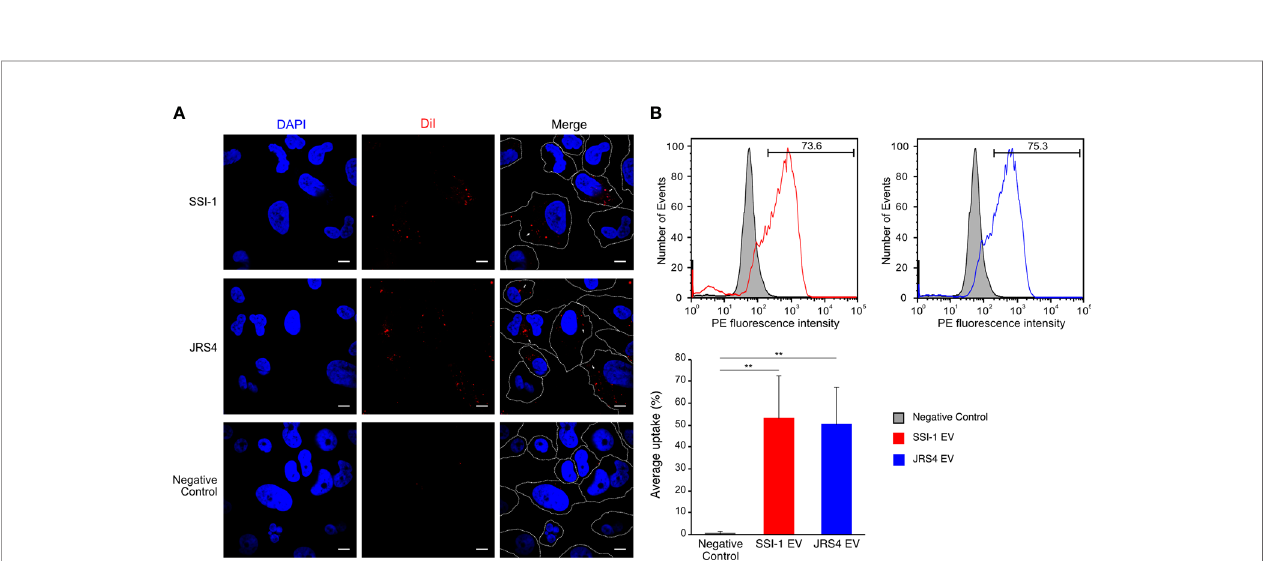
FIGURE 4 | Uptake of DiI-labeled EVs and the ef fi ciency in dTHP-1 cells. (A) The dTHP-1 cells were co-incubated with 10 µg of DiI-labled EVs (red) solution for 2 h at 37°C and 4°C (shown in Supplementary Figure 3 ) and observed by confocal fl uorescence microscopy. Cellular DNA was stained with DAPI (blue). Scale bar, 5 µm. Dot lines indicate the border of individual cells. (B) Flow cytometric analysis of the fl uorescence transferred by EVs into dTHP-1 cells. The staining of directly labelled cells and the negative control (cells treated with 4 µM DiI solution) are shown as overlays. The PE fl uorescence intensity was measured after 2 h incubation period. Average percentage uptake of DiI-labelled EVs into dTHP-1 cells was represented by bar chart with standard deviation of independent experiments. P-values calculated by two-tailed Student ’ s t-test. **P < 0.01.